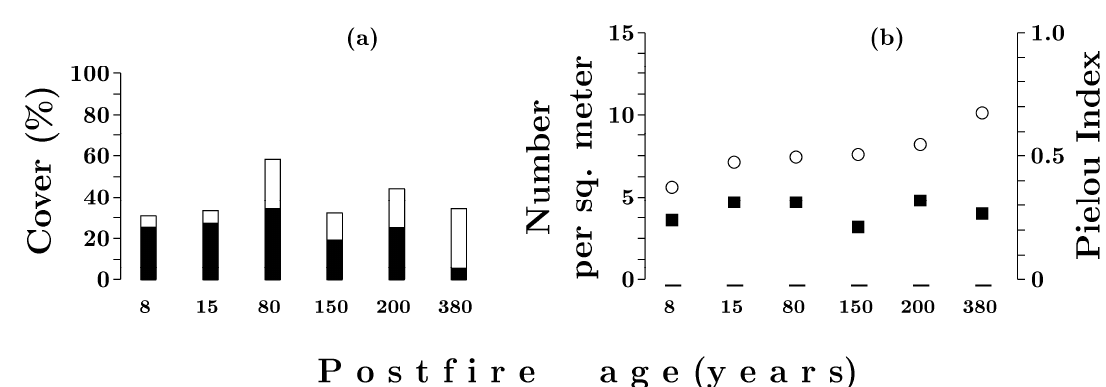
Figure 7. Total cover ( a ) of dwarf shrub and herb layer and cover by Vaccinium myrtillus (solid bars). Diversity characteristics ( b ): solid squares—number of species; open circles—Pielou’s index in forests with different post-fire periods.